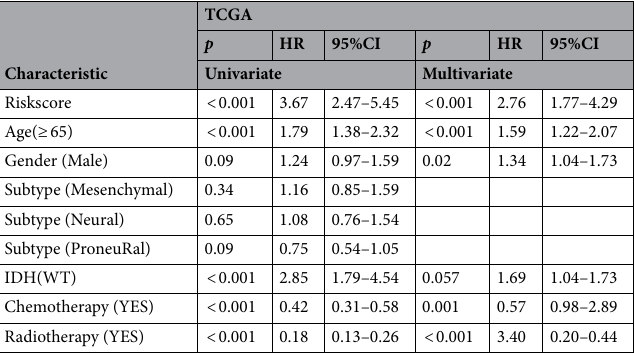
Table 2. Univariate and multivariate cox proportional hazards analysis of clinicopathological variables and hypoxia signature based on overall survival (OS) in the TCGA GBM